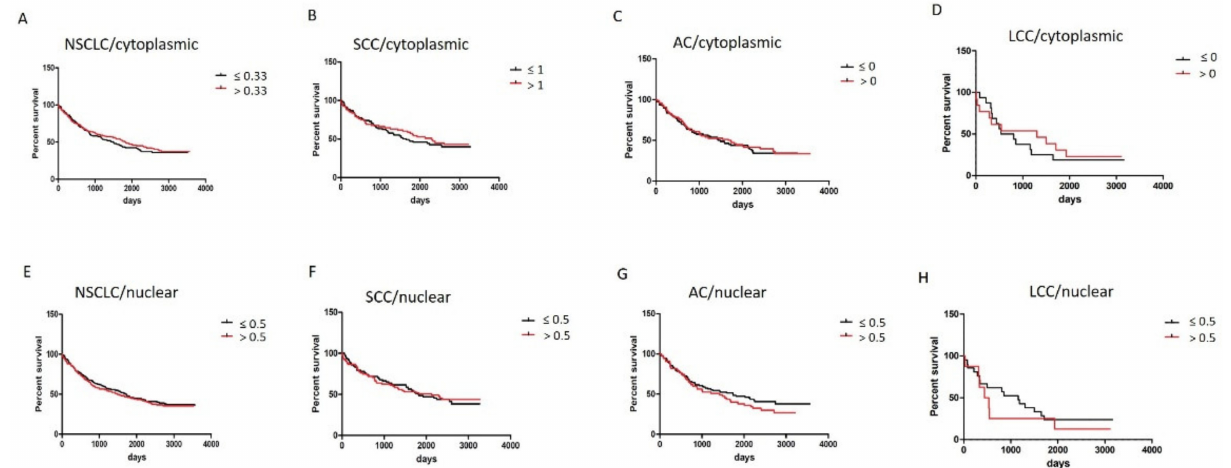
Figure 12. Survival analyses of NSCLC patients in relation to cytoplasmic/nuclear ZYX expression in the cells of NSCLC ( A , E , respectively), SCC ( B , F , respectively), AC ( C , G , respectively), and LCC subtypes ( D , H , respectively). The cut-off point was established in relation to the median value. Analyses of different ZYX expression groups (low/high level) in relation to survivals of patients demonstrated that overall survivals of NSCLC (in total), SCC, and AC patients were similar in each group (Figure 13A–D). The differences were observed in the case of LCC patients who had shorter OS in comparison with NSCLC, SCC, and AC